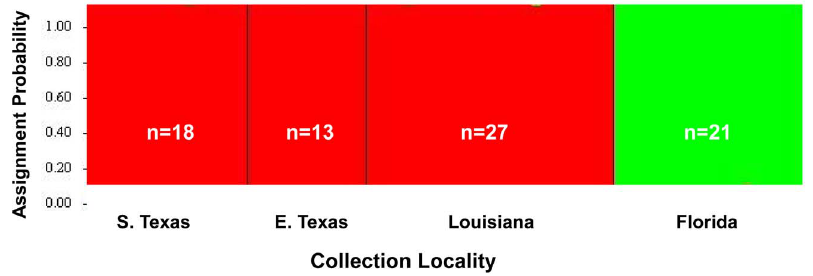
Figure 2. Structure 2.2 analysis depicts two genetically distinct clusters of D.saccharalis . Individuals from southern Texas (S. Texas), eastern Texas (E. Texas) and Louisiana grouped together within the red cluster, while individuals from Florida grouped within the green cluster. The y-axis shows the probability of each individual to belong to a genetically distinct cluster. The number of individuals from each region used for the analysis is represented by